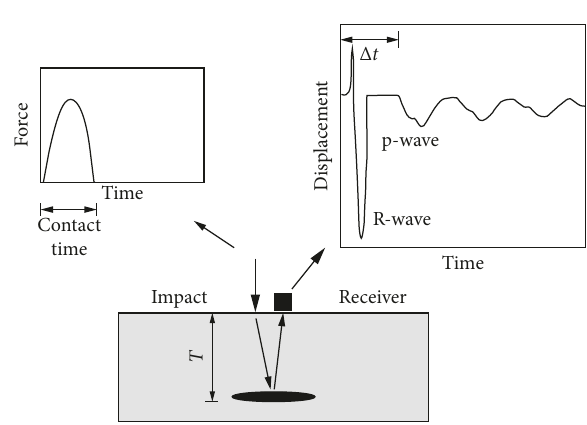
Figure 2: Principle of the impact-echo method